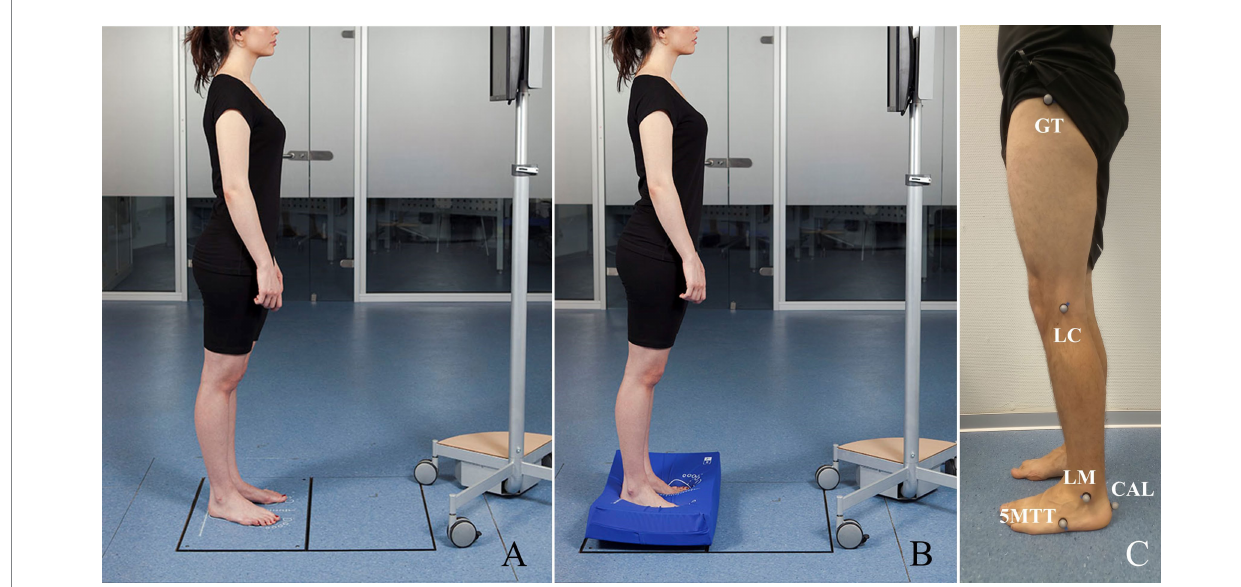
FIGURE 2 Static balance test. (A) Protocol for the Romberg test without a foam rubber and for the visual, verbal, lower and upper motor static functional test. (B) Protocol for the Romberg test with a foam rubber under the feet. (C) Gait model composed by tuberosity of fifth metatarsal (5MTT),